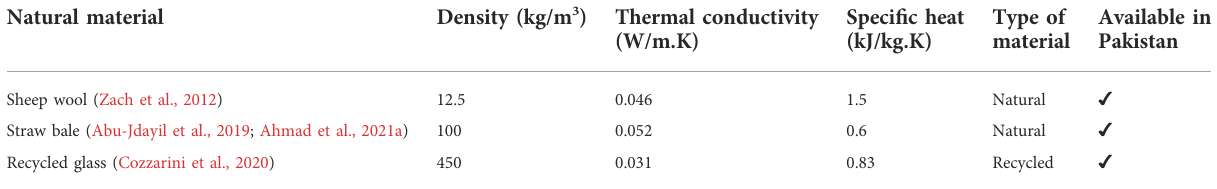
TABLE 3 Properties of thermal insulation materials, concrete, and air. Natural